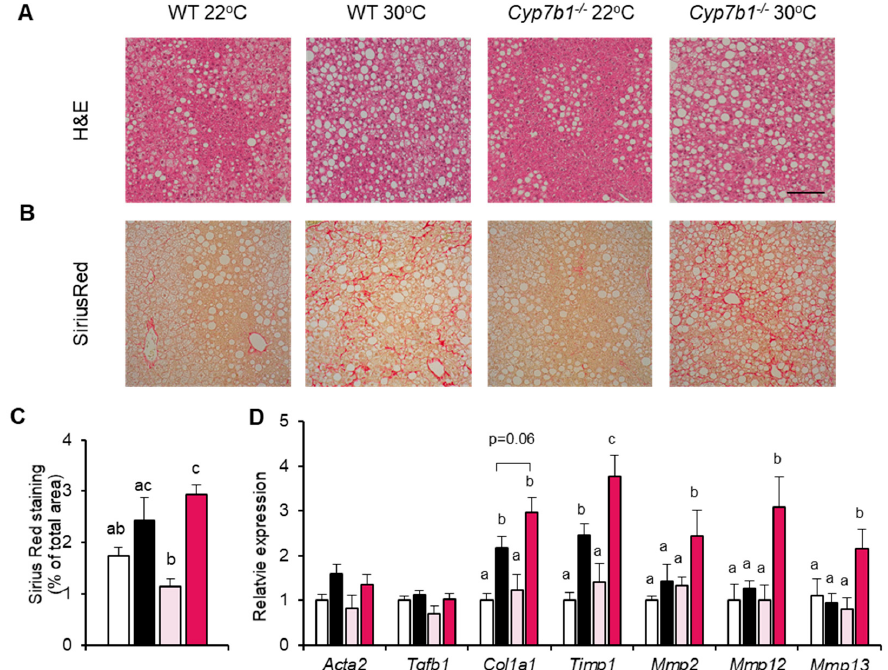
Figure 3. Increased fibrosis in CYP7B1-deficient mice housed at thermoneutrality. Cyp7b1 − / − and WT littermates housed under 22 °C or 30 °C were fed a CD-HFD for 8 months. Representative images of ( A ) HE and ( B ) Sirius red stained liver sections. ( C ) Quantification of fibrotic areas (number of mice: WT 22°C: n= 11; WT 30°C: n = 9; Cyp7b1 − / − 22 °C: n = 16; Cyp7b1 − / − 30 °C: n = 13). ( D ) Hepatic expression of fibrosis-related genes normalized to Tbp as a housekeeper (n = 8). Data are shown as mean values ± SEM. Different letters indicate significant differences between groups ( p < 0.05) determined by two-way ANOVA.